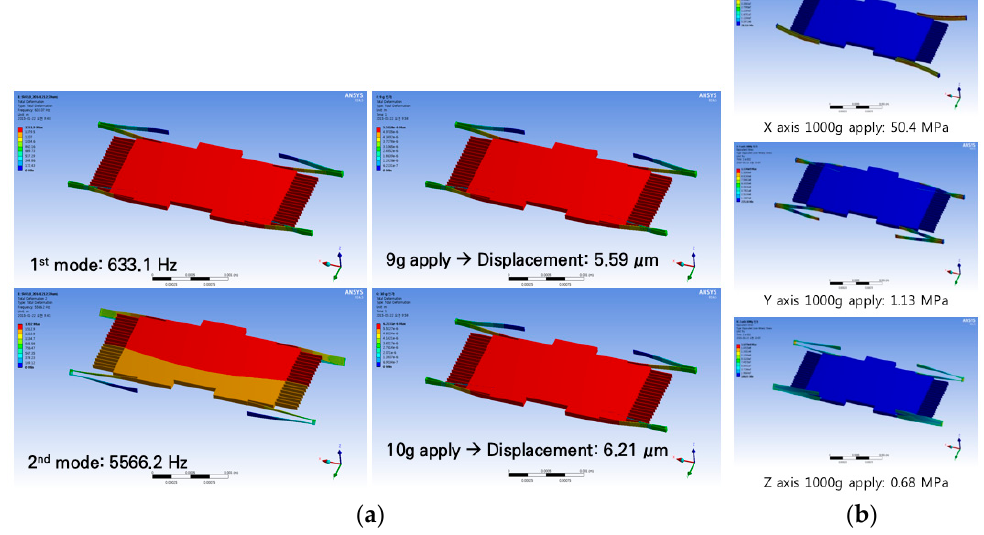
Figure 2. ( a ) Simulation results of MEMS switching; ( b ) FEM analysis of MEMS